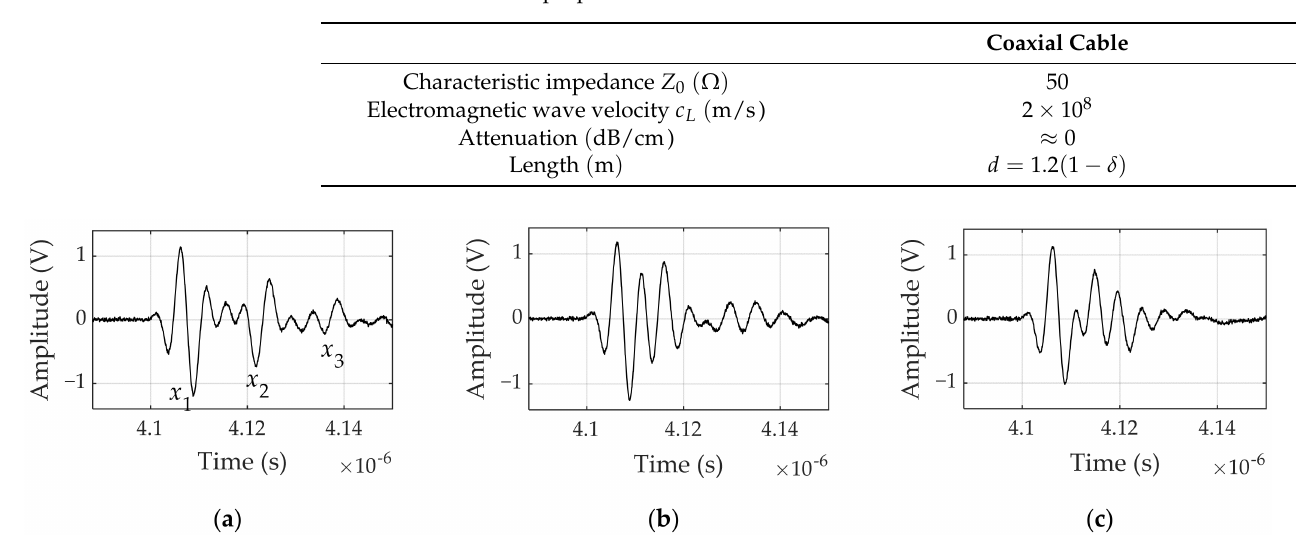
Table 4. Coaxial cable properties.